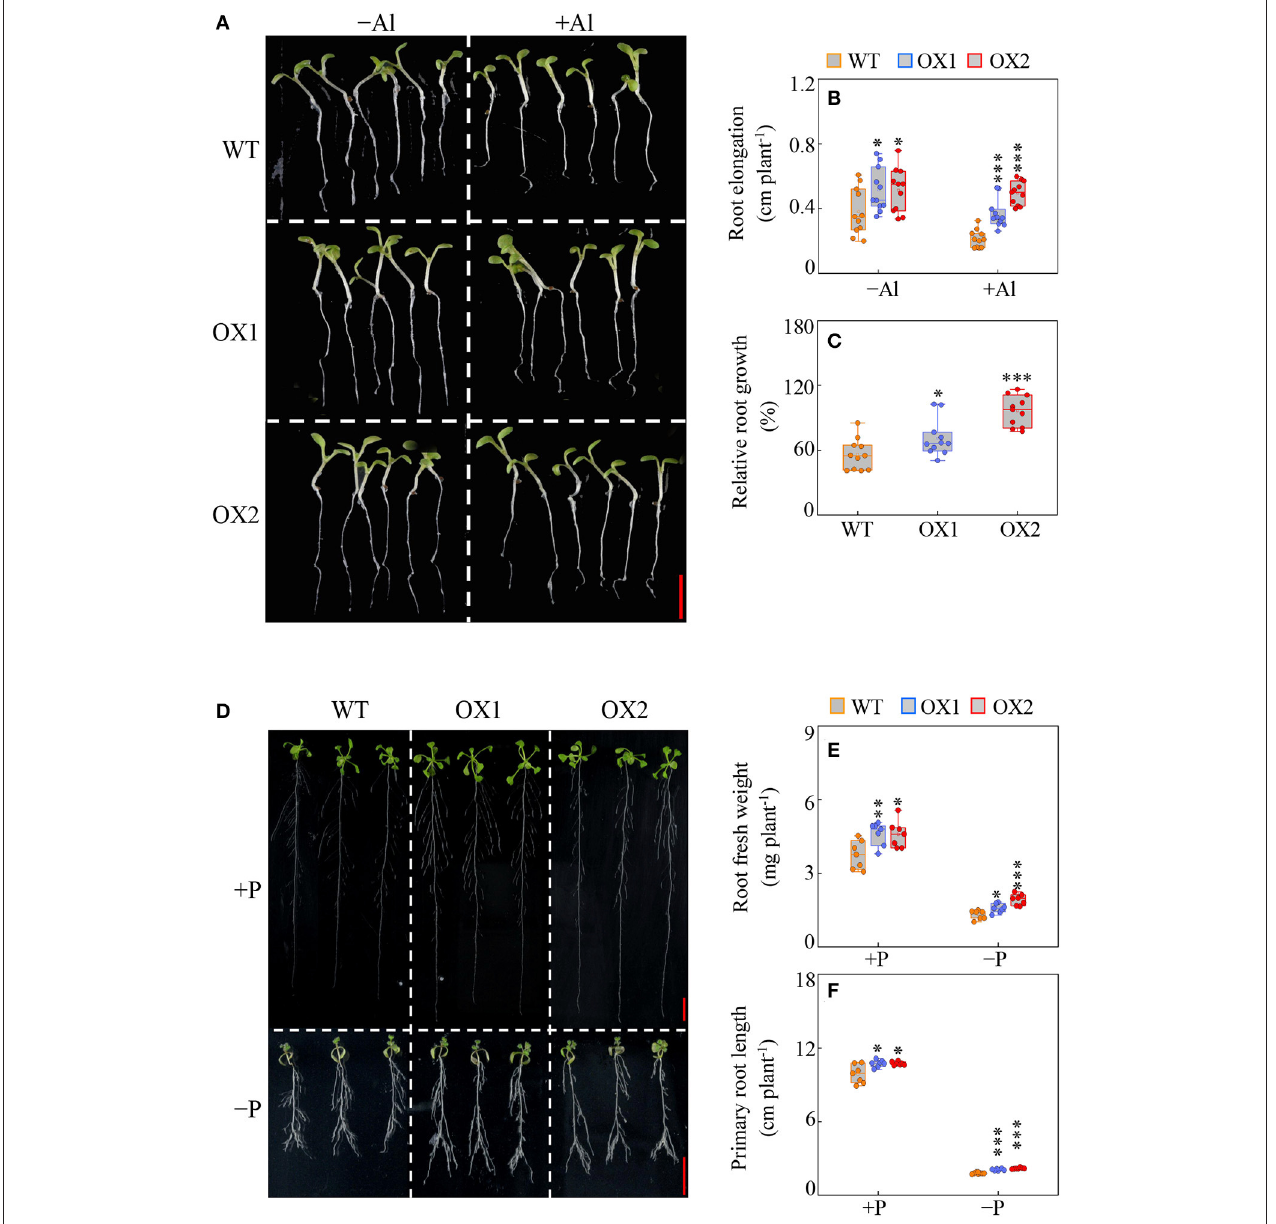
FIGURE 5 | Effects of GmBBE-like43 overexpression on Arabidopsis root growth in response to Al toxicity and Pi starvation. (A–C) Phenotypes (A) , root elongation (B) , and relative root growth (C) of wild-type (WT) and GmBBE-like43 -overexpression (OX1 and OX2) lines treated with or without 5 µ M AlCl 3 for 48h, Bar = 0.5mm; (D–F) Phenotypes (D) , root fresh weight (E) , and primary root length (F) of WT, OX1, and OX2 treated with either 1250 µ M ( + P) or 6.25 µ M (–P) KH 2 PO 4 for 9 days, Bar = 1cm. Asterisks indicates significant difference between WT and OX according to the Student’s t -test: * : P < 0.05; ** : 0.001 < P < 0.01; *** : P < 0.001.